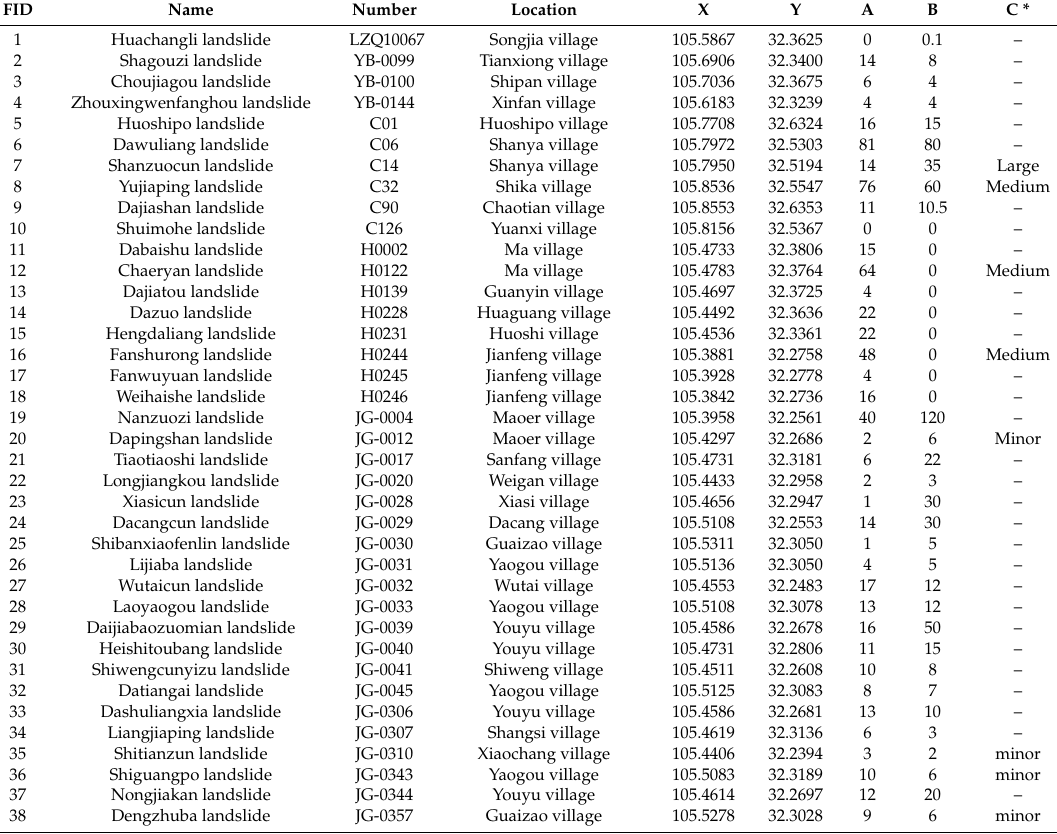
Table A2. Details of new landslide catalog